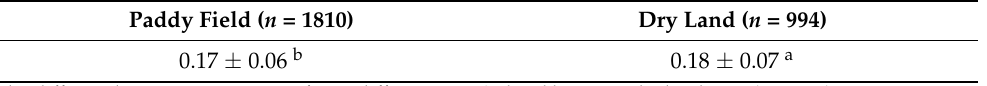
Table 5. Test of interaction of main environmental factors on Se content (two-way ANOVA). Item Factor Sum of Squares df Mean Square F Sig SOM and Par 0.90 Se